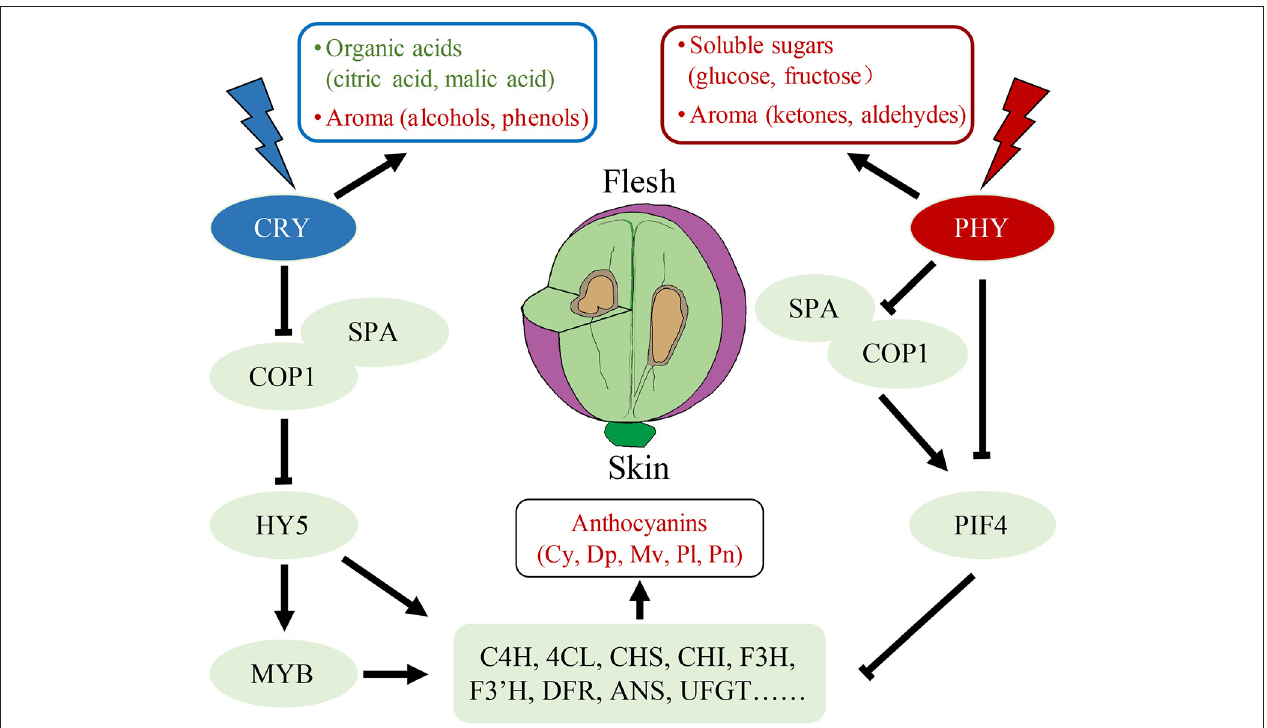
FIGURE 6 | A model of fruit quality traits formation under red light and blue light treatments. Red represents up-regulation while green represents the down-regulation. Cy: cyanidin-3- O -glucoside, Dp: delphinidin-3- O -glucoside, Mv: malvidin-3- O -glucoside, Pl: pelargonidin 3- O -glucoside, Pn: peonidin-3- O